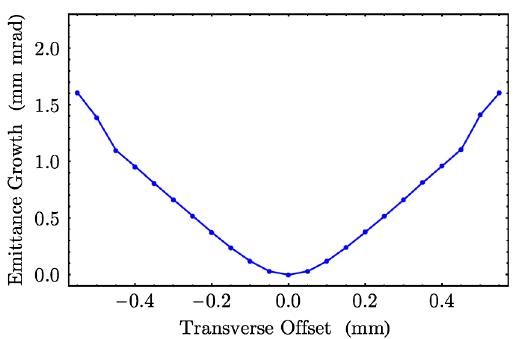
FIG. 9. Normalized bunch emittance growth calculated by PARMELA as a function of transverse offset of the solenoid. The photoinjector and bunch parameters are the same as those discussed for Fig.